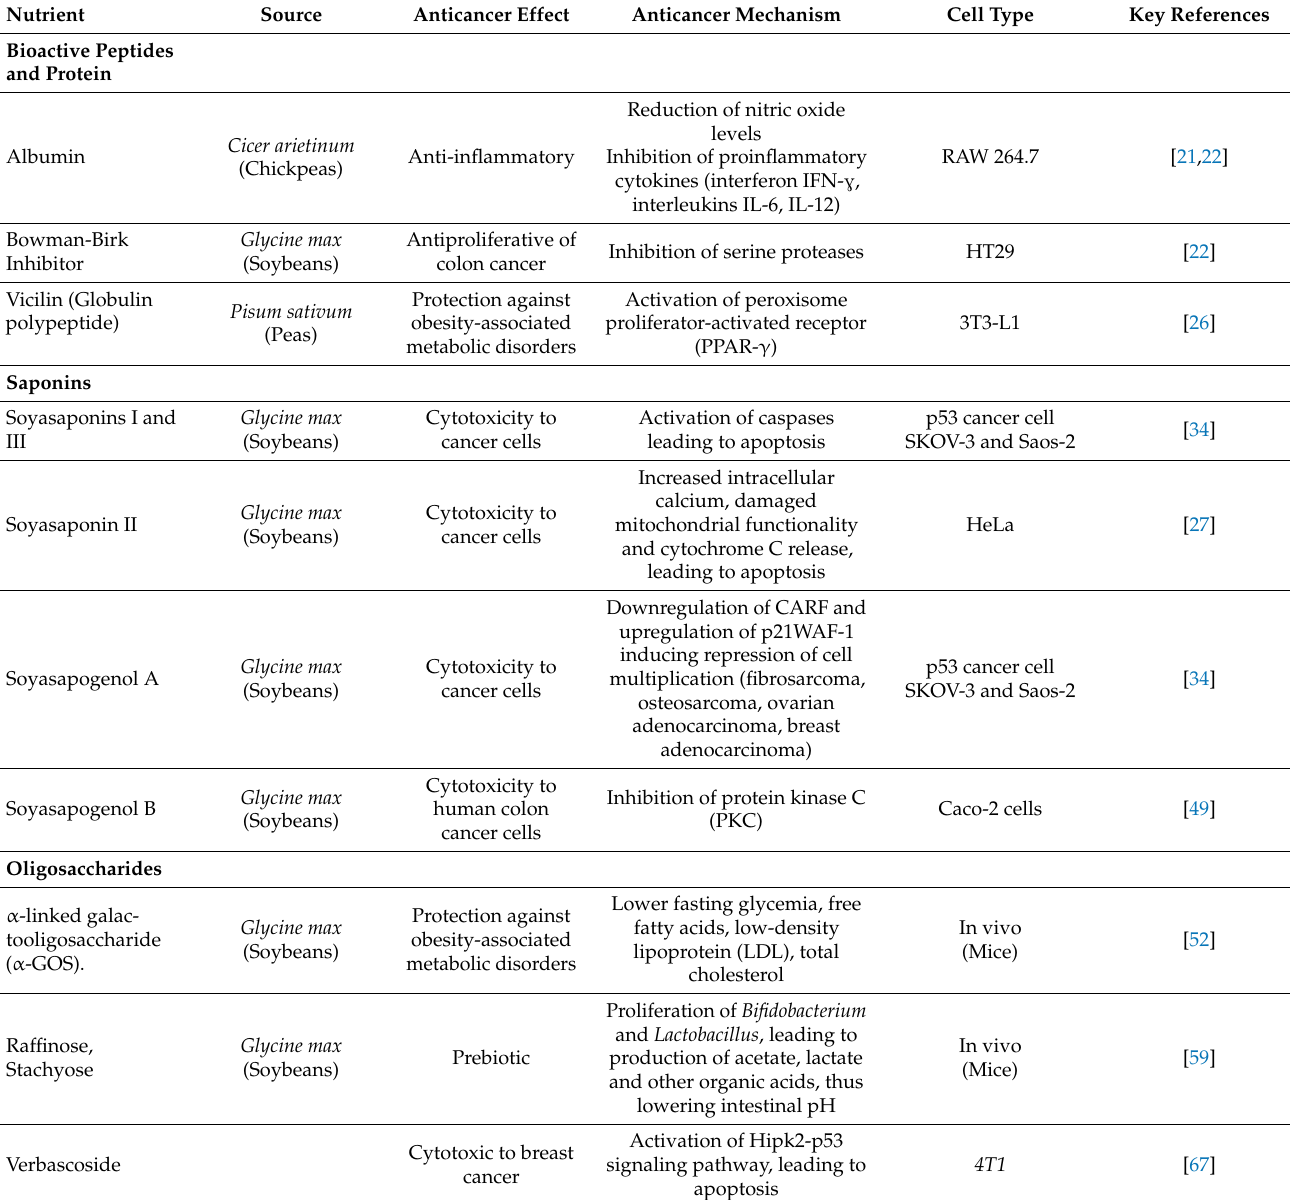
Table 2. Key anticancer mechanisms of soluble nutrients from